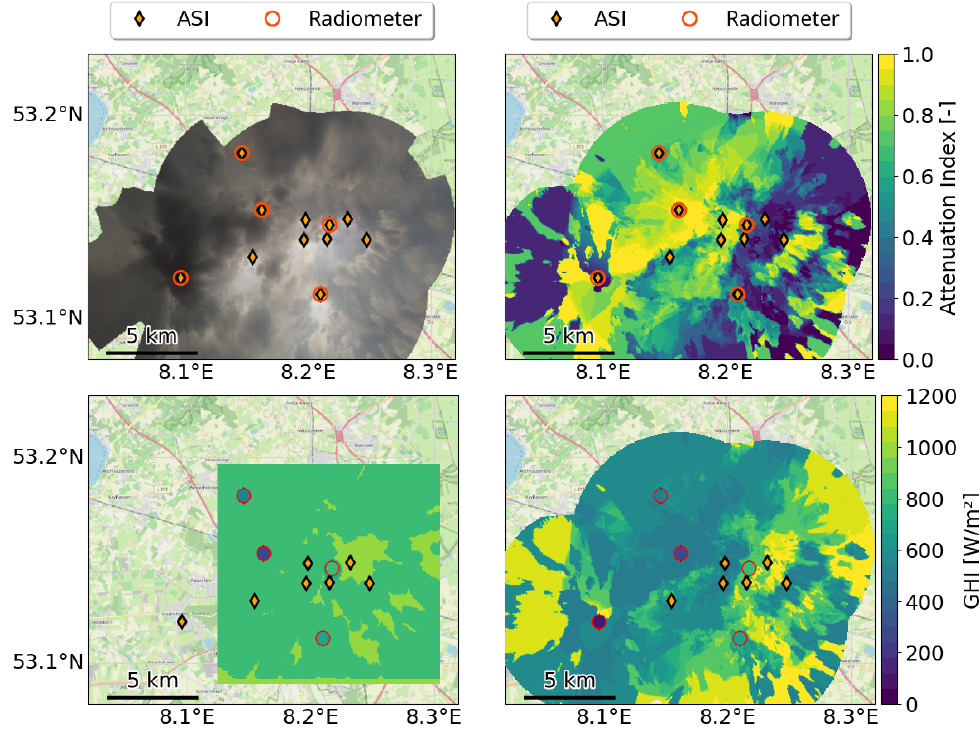
Figure 9. This figure shows an exemplary multi-cloud-layer situation over Oldenburg on 27 June 2020 11:27:00. The figure is created analogous to Figure 8. The panels’ contents are described in Figure 8. (background: © OpenStreetMap contributors 2022. Distributed under a Creative Commons BY-SA